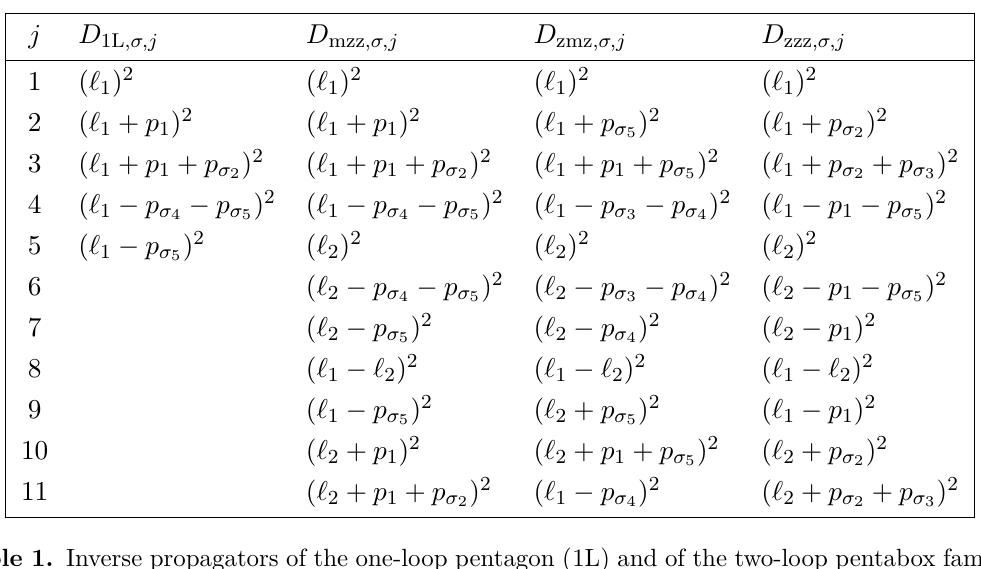
Table 1. Inverse propagators of the one-loop pentagon ( 1L ) and of the two-loop pentabox families ( mzz , zmz and zzz ) for all permutations σ = ( σ 2 σ 3 σ 4 σ 5 ) of the external massless legs. The repre-